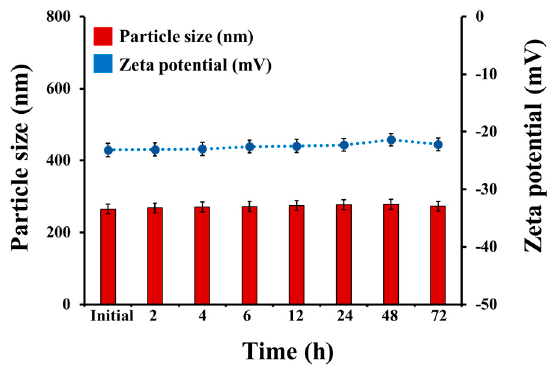
Figure 3. Physical stability of Cur-CS/Alg NPs in cell culture medium (pH 7.4) ( n = 3).